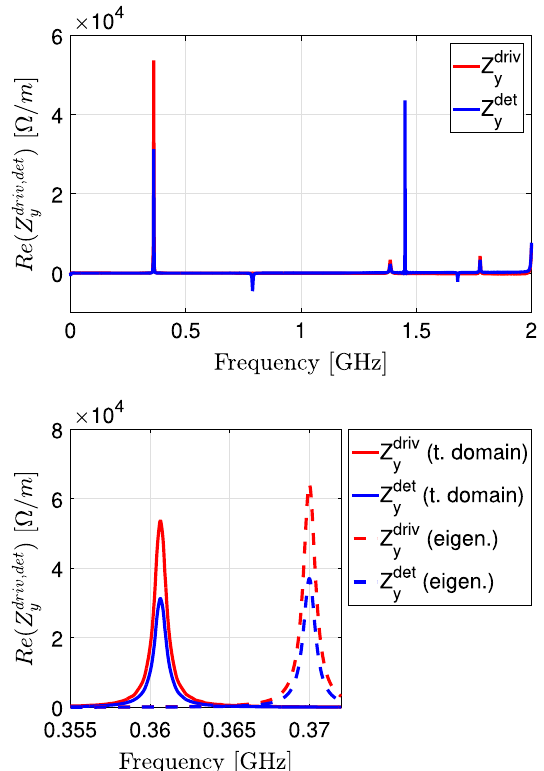
6. Top: Wakefield calculation of the vertical transverse impedance in the roman pot structure. Bottom: A zoom-in on the most prominent peak, and a comparison to the eigenmode simulation.